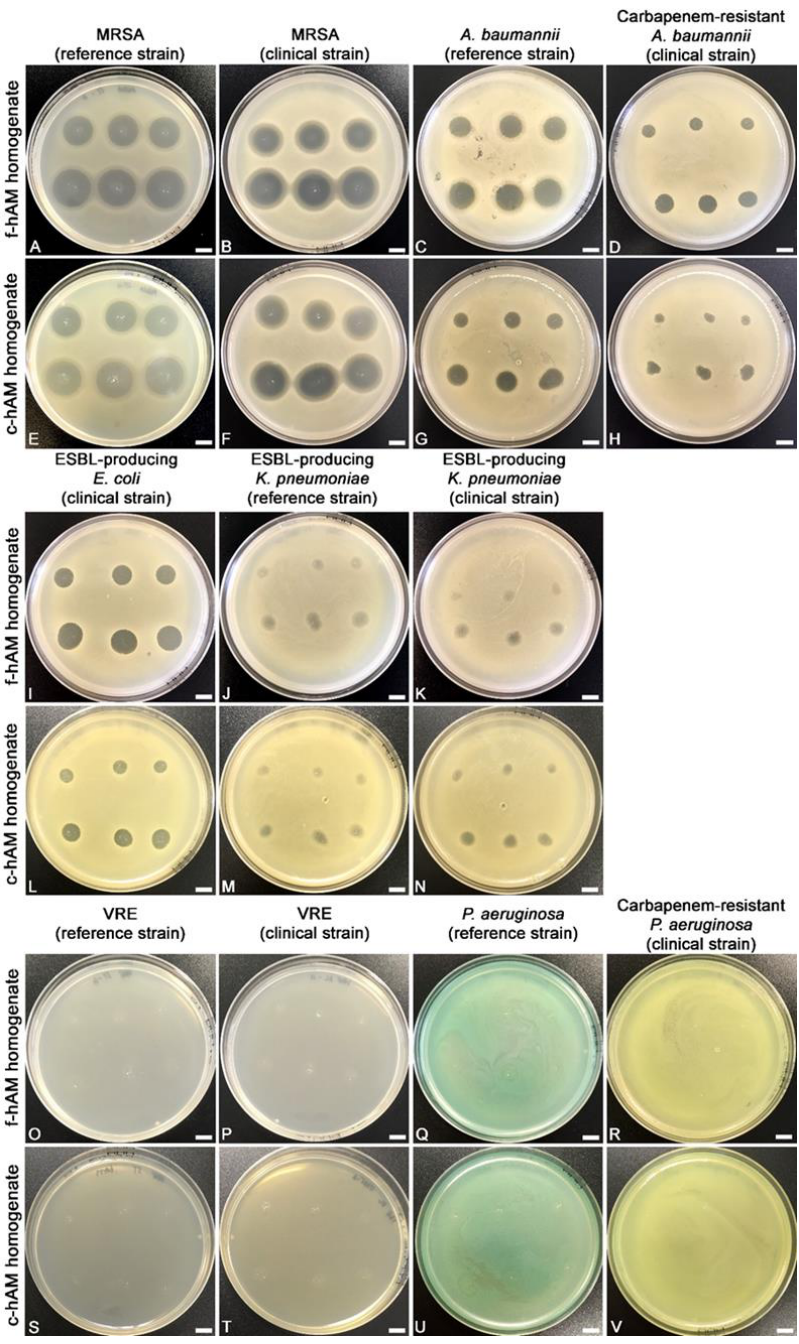
Figure 2. The f-hAM and c-hAM homogenates have antibacterial activity against seven out of 11 tested strains. ( A , B , E , F , I , L ) The application of f-hAM and c-hAM homogenates resulted in an inhibition zone in all the tests. ( C , D , G , H ) The application of f-hAM and c-hAM homogenates resulted in an inhibition zone in 75% of all the performed tests. ( J , K , M , N ) The application of f-hAM and c-hAM homogenates resulted in an inhibition zone in 25% of the performed tests. ( O – V ) The application of f-hAM and c-hAM homogenates did not result in an inhibition zone in any of the performed tests. Data were obtained from at least three independent replications of experiments using at least three biological samples of hAM and six technical repeats for each biological sample and each independent replication of the experiment. Scale bars: 10